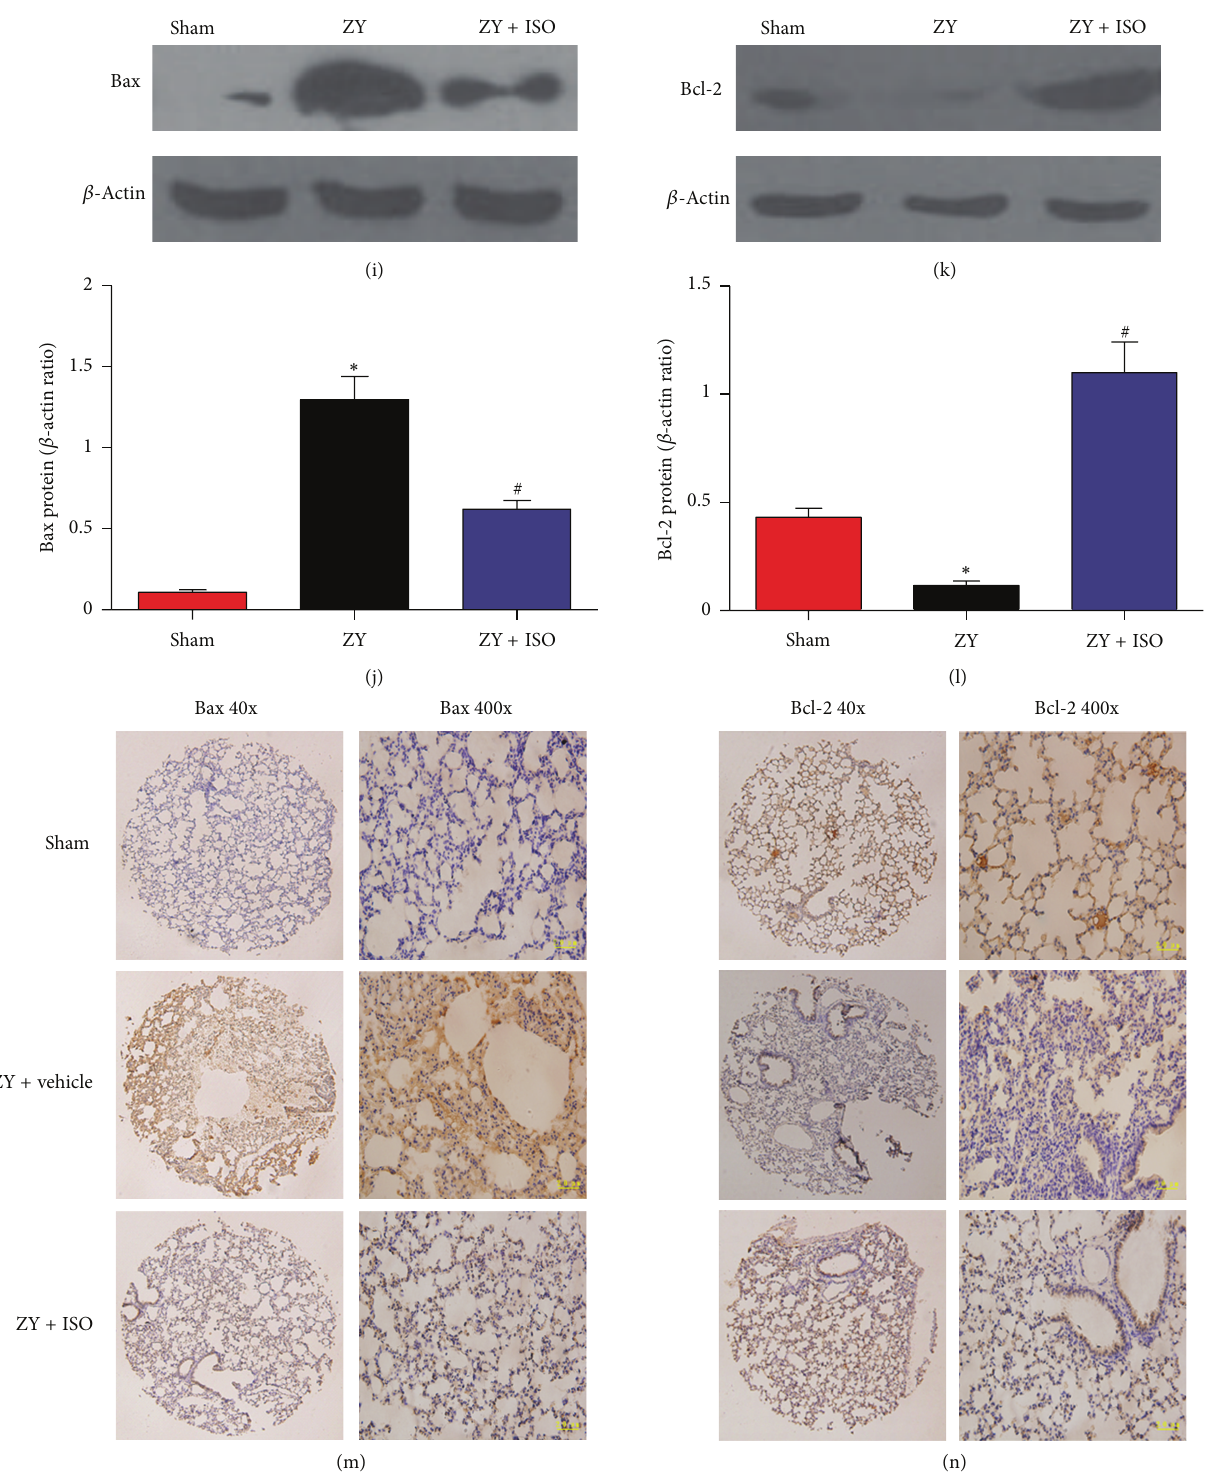
Figure 6: Treatment with 1.4% ISO inhibits pulmonary cell apoptosis in ZY-challenged mice. Western blot analysis for expression of procaspase-8 (a), cleaved caspase-8 (c), procaspase-3 (e), cleaved caspase-3 (g), Bax (i), and Bcl-2 (k); protein bands were densitometrically quantified and relative amounts of procaspase-8 (b), cleaved caspase-8 (d), procaspase-3 (f), cleaved caspase-3 (h), Bax (j), and Bcl-2 (l) are shown; histologic sections were stained with anti-Bax antibody ((m); 40x or 400x magnification) and anti-Bcl-2 antibody ((n); 40x or 400x magnification). The respective densitometric analysis of protein bands is from three separate experiments. Immunohistochemistry figures are representative of at least three experiments performed on different experimental days. The animals were treated as described in Figure 1. Data are mean ± SD ( 𝑛 = 10 mice per group). ∗ 𝑃 < 0.05 versus sham; # 𝑃 < 0.05 versus ZY +